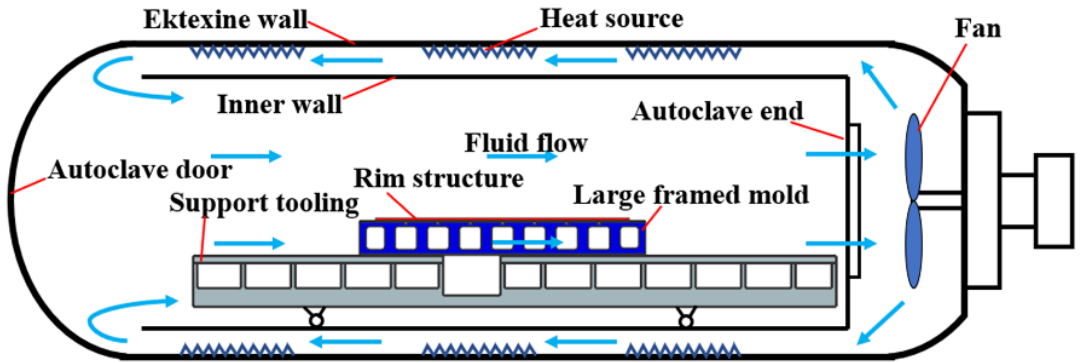
Figure 1. Schematic diagram of the autoclave.